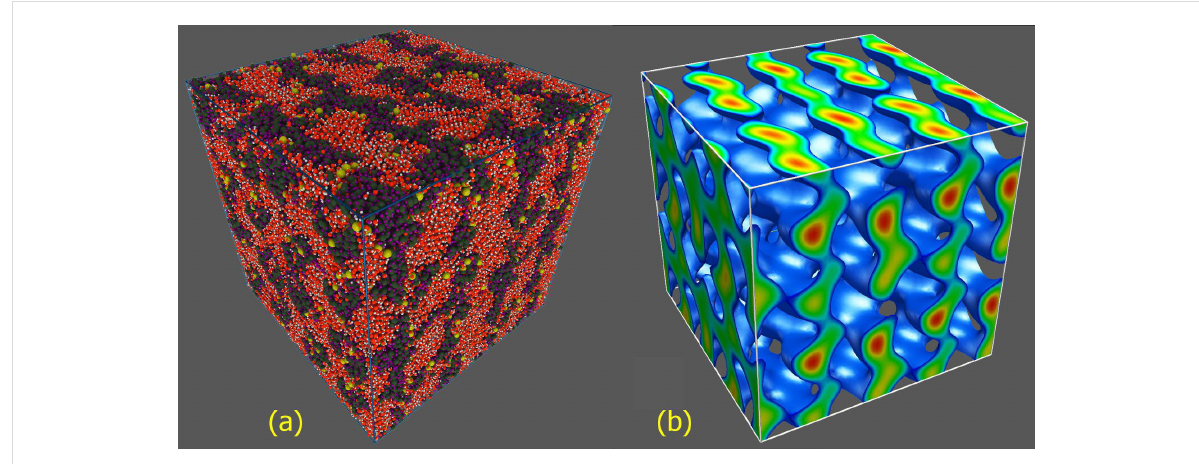
Figure 6: (a) Atomistic representation of the 524,864-atom system and (b) the isodensity surface that demonstrates the distribution of water oxygen atoms in the same system.